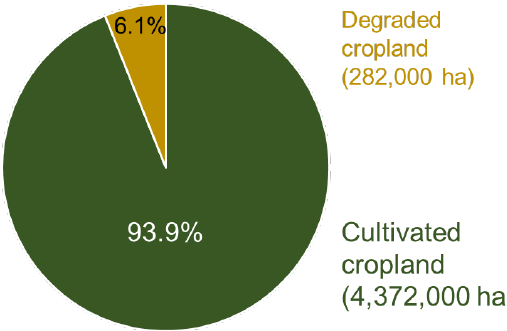
Figure 4. Percentage of cultivated and degraded croplands in Japan as of the end of 2020 [22].